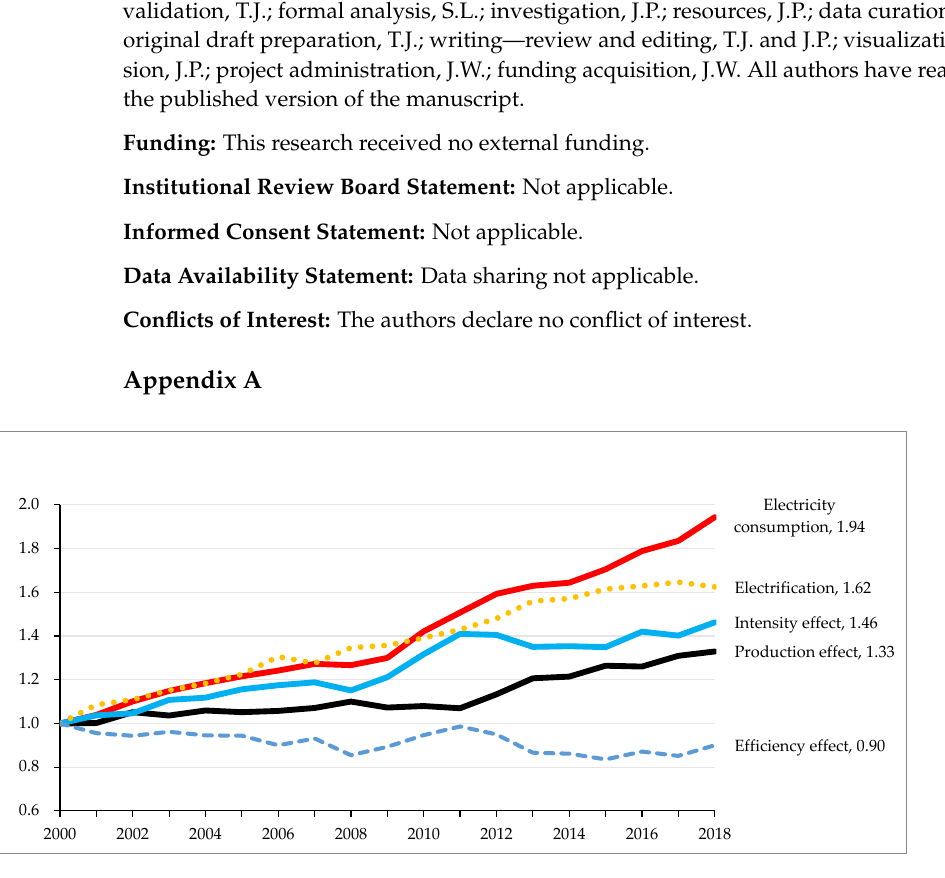
Figure A2. Textile and leather electricity consumption LMDI results (fixed base year, multiplica- tive).